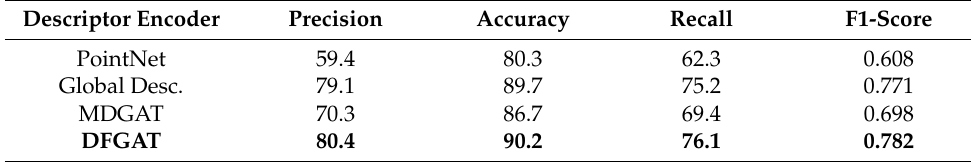
Table 4. Ablation of descriptor encoder.